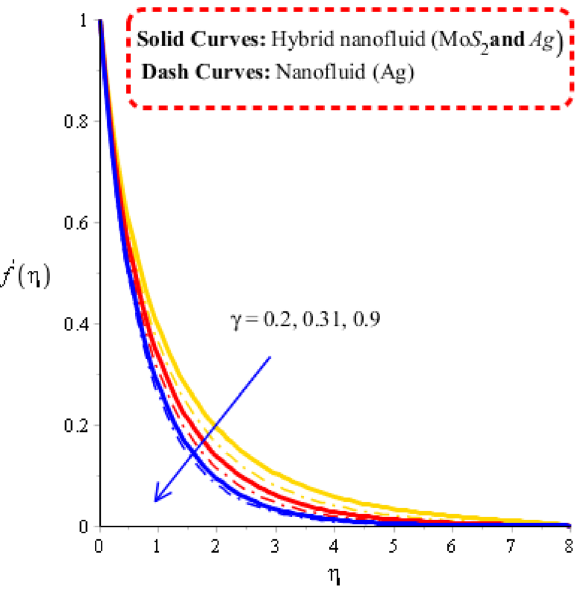
1.6, (cid:31) 1.2, Fr 2.0, Pr 204, Hs 0.7, (cid:31) 1.4, ∗ = = = = = =